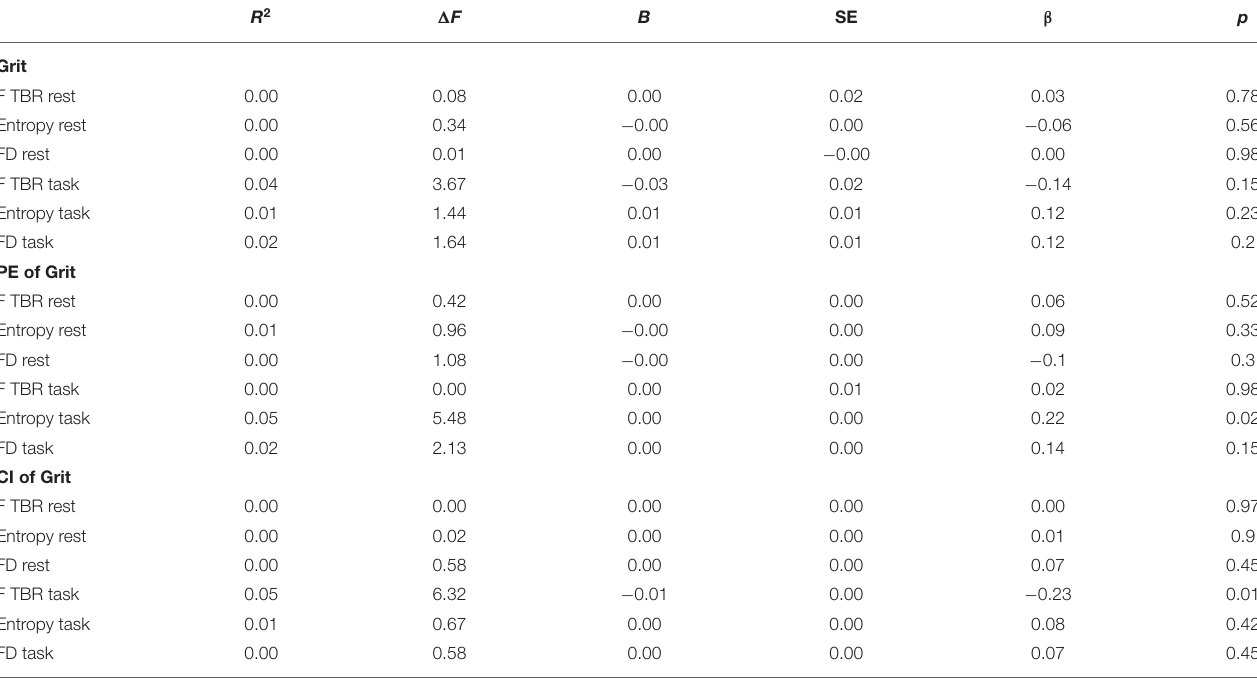
TABLE 6 | Hierarchical regression analyses of grit and its two factors over neural indices (frontal TBR, entropy, and FD) during rest and during the task controlling for impulsiveness, gender, age, education and work experience. R 2 1 F B SE